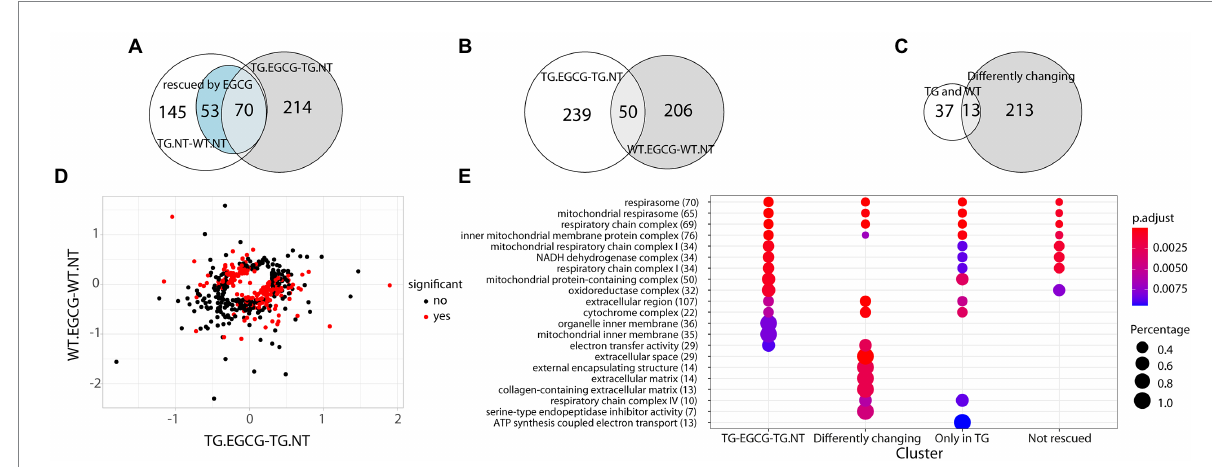
FIGURE 3 Dyrk1A overexpression extend beyond the network and differently affect wt and TgDYRK1A mice (A) Venn diagram showing the overlap between proteins changing their abundance in TG mice, protein changing upon EGCG-containing green tea extract treatment in TG mice, and the ones rescued. (B) Venn diagram showing the overlap between the proteins changing in TG mice upon treatment and the ones changing in WT. (C) Venn diagram showing the overlap between protein changing in both TG and WT mice upon EGCG-containing green tea extract treatment and the ones exhibiting a genotype-specific response to EGCG-containing green tea extract treatment (D) Plot comparing protein fold changes upon EGCG treatment in TG mice ( x -axis), and wild-type mice ( y -axis). Proteins with a significant interaction in the contrast (TG.EGCG-TG.NT) − (WT. EGCG-WT.NT) , where NT stands for “not treated,” are indicated as red dots. (E) Enrichment analysis for biological processes, molecular functions, and cell components upon EGCG-containing green tea extract treatment in TG. The color-gradient indicates the adjusted p -value for the enrichment. Numbers in parentheses indicate the number of identified proteins in each category. Dot size corresponds to (protein count for each group)/(total protein count for each category). Only categories with an FDR < 1% are shown.